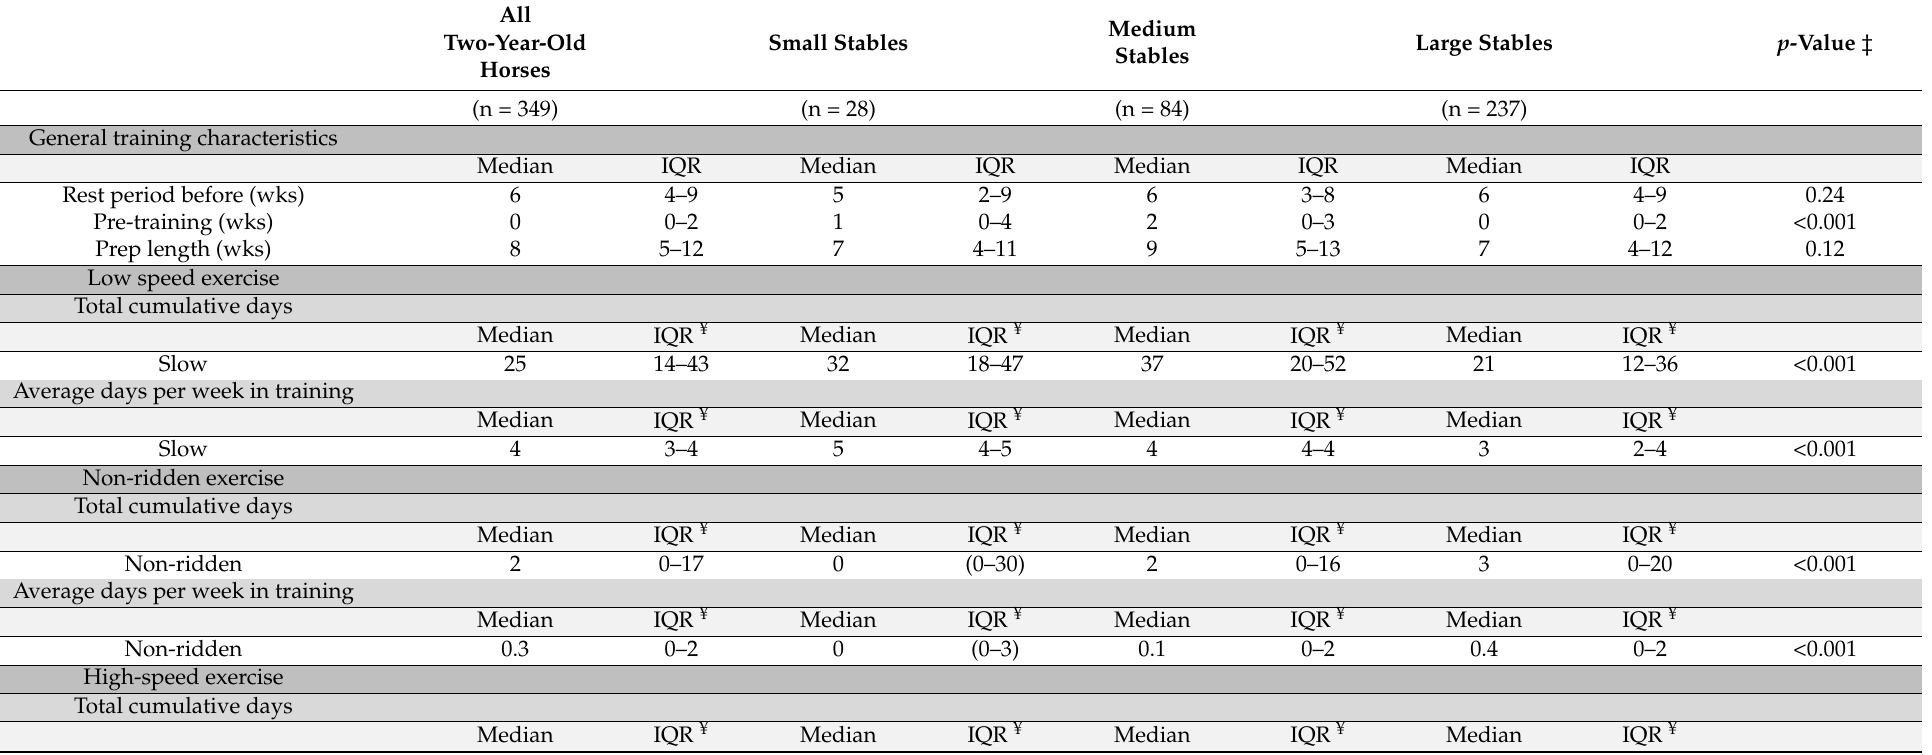
Medium Large Stables p -Value Stables